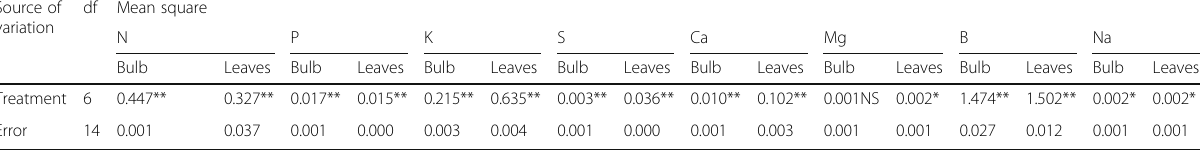
Table 9 Analysis of variance of N, P, K, S, Ca, Mg, B and Na contents of garlic Source of df Mean square variation N Treatment 6